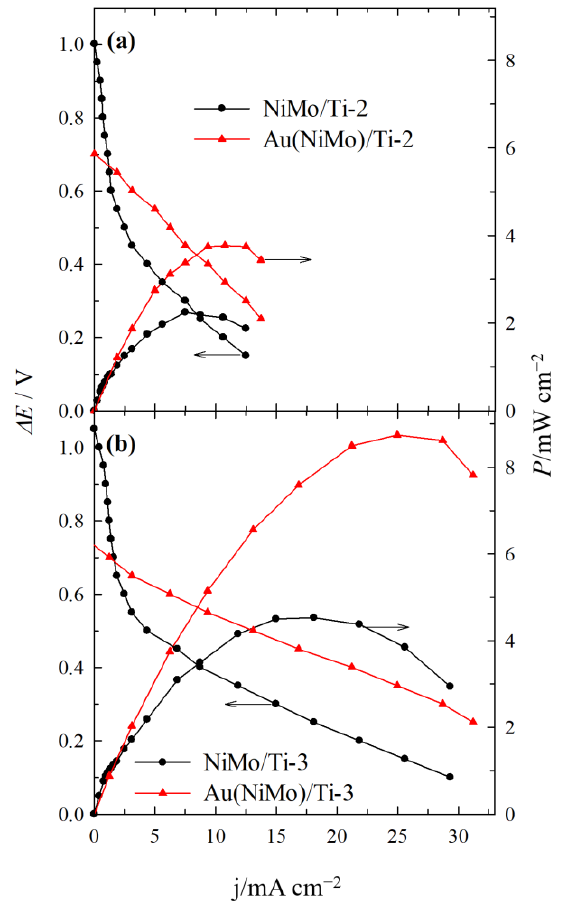
Figure 10. Cell polarization and power density curves for the C 6 H 12 O 6 -H 2 O 2 fuel cell using NiMo/Ti- 2 ( a ), NiMo/Ti-3 ( b ), Au(NiMo)/Ti-2 ( a ), and Au(NiMo)/Ti-3 ( b ) anode coating with anolyte consisted of 0.1 M C 6 H 12 O 6 + 1 M NaOH and 5 M H 2 O 2 + 1.5 M HCl catholyte at 25 ◦ C.